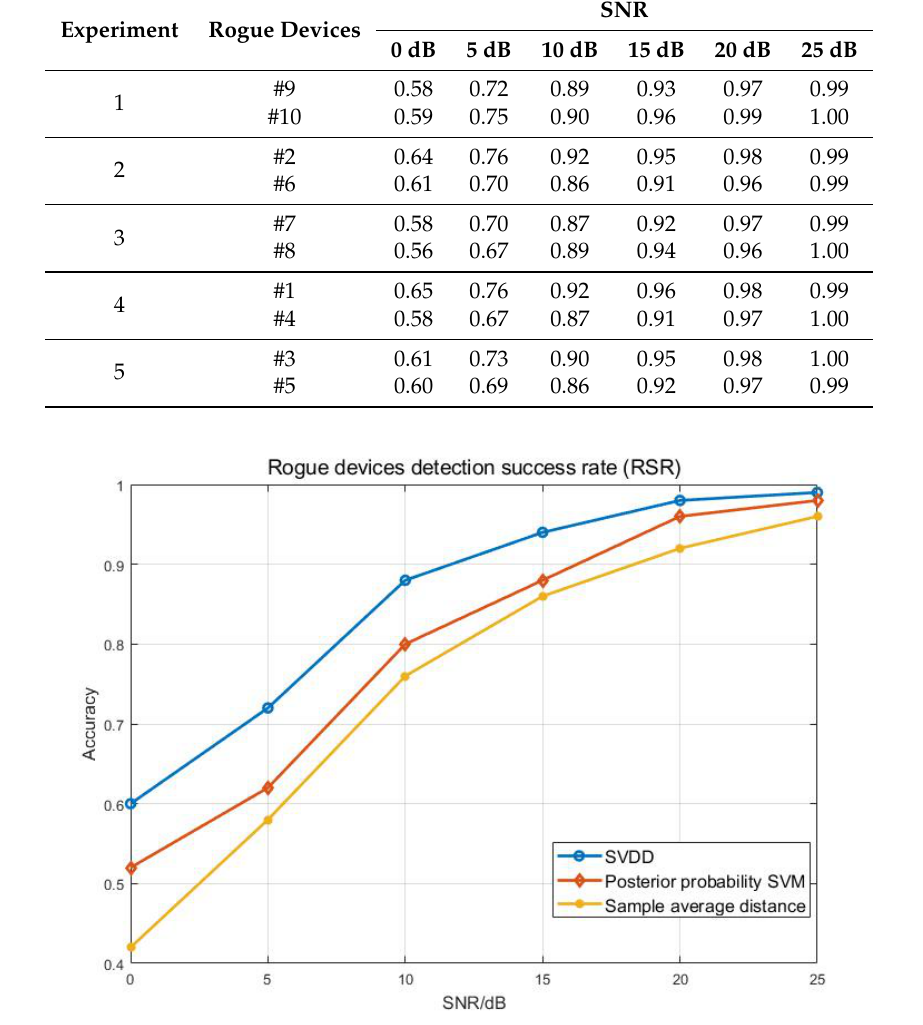
Table 3. Rogue devices detection success rate (RSR) for the SVDD model.